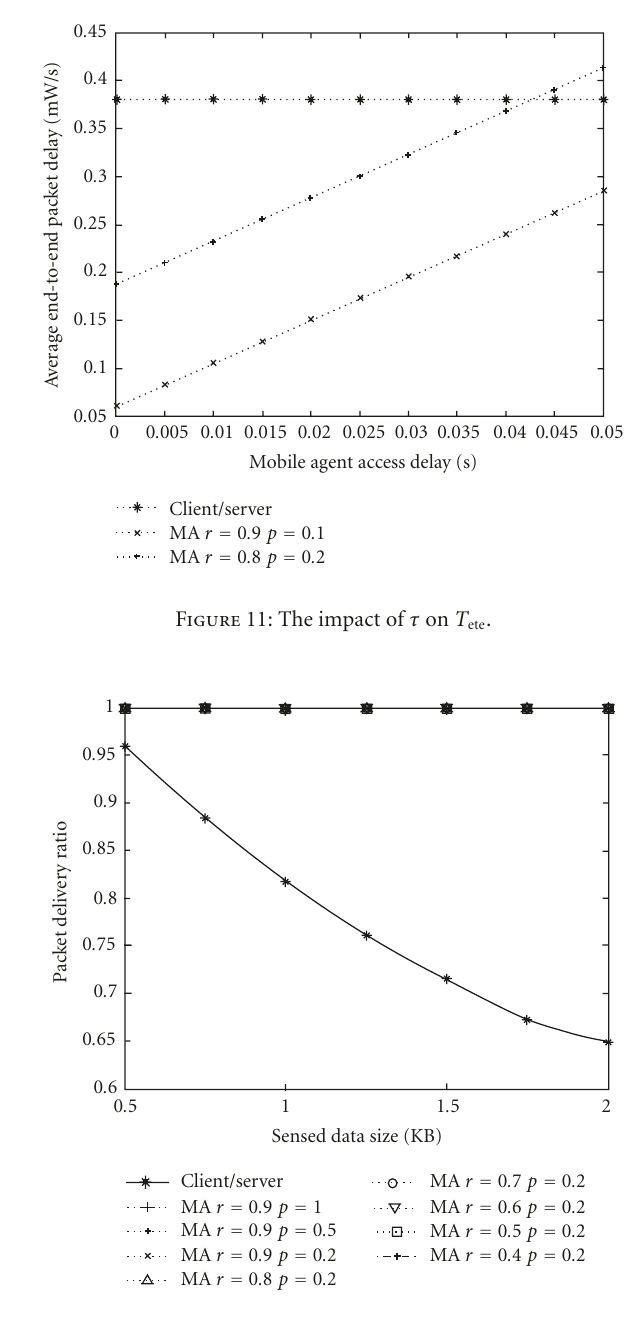
Figure 12: The impact of S data , r , and ρ on P